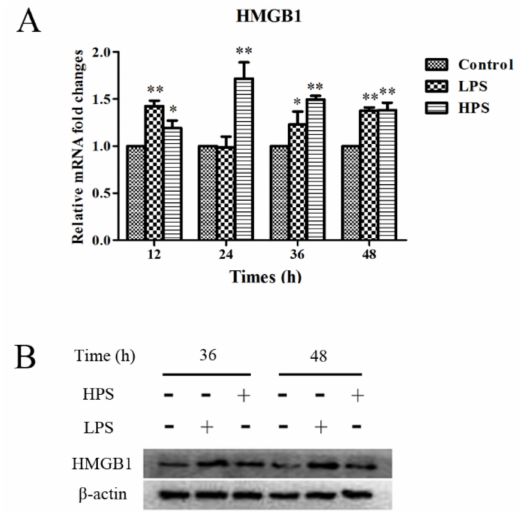
Figure 1. Detection of high-mobility group box 1 (HMGB1) release in the piglet peripheral blood monocytes triggered by H. parasuis or lipopolysaccharide (LPS) using the real-time quantitative reverse transcription polymerase chain reaction (qRT-PCR) method ( A ) and Western blot method ( B ). * p < 0.05; ** p < 0.01; HPS: H. parasuis ; 36 h: LPS vs. Control ( p < 0.01) and HPS vs. Control ( p < 0.01); 48 h: LPS vs. Control ( p < 0.01) and HPS vs. Control ( p <